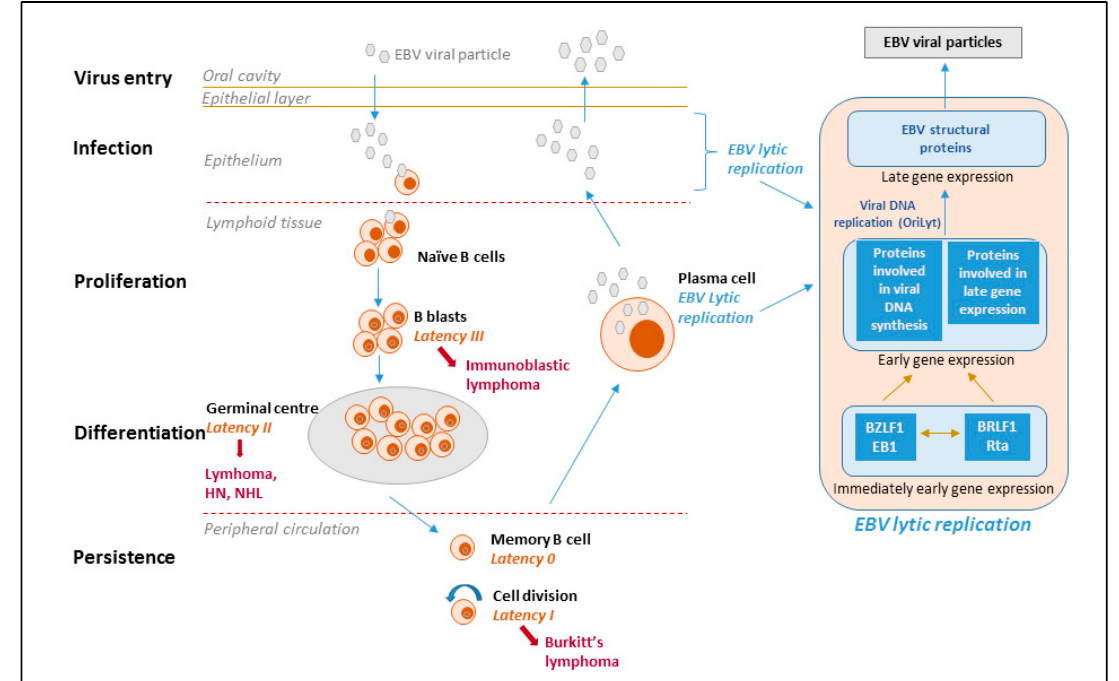
Figure 1. EBV life cycle, latency stages and derived lymphomas. The viral life cycle includes at least five different stages (virus entry, infection, proliferation, differentiation and persistence), and four of them are associated with EBV diseases. The virus is transmitted through the saliva and infects naïve B-cells in the oropharyngeal mucosa. During primary infection, EBV-infected naïve B-cells express the entire latency gene complex (10 proteins: EBV nuclear antigens (EBNAs), latent membrane protein (LMPs)) as well as EBV-encoded small RNAs (EBERs) and microRNAs. This is called type III latency and this form of latency activates the resting B-cells and drives them to proliferation and transformation. However, these cells are highly immunogenic and are rapidly eliminated by EBV-specific T cells. The virus is able to survive in B-cells because it downregulates its immunogenic proteins. EBV mimics antigen driven B-cell responses and similar to antigen-stimulated blasts, the EBV-infected B-cells enter the follicles, expand, and form germinal centers where they express only three viral proteins (type II latency). Finally, they exit the lymph node expressing only a single viral protein (EBNA1, which ensures that the viral genome divides with the cellular genome) (type I latency). The entry of EBV-infected cells into the peripheral blood results in the shutdown of all viral genes encoding for proteins; this is called latency 0 or latency program where no viral proteins are expressed. Resting memory cells, in which the virus is quiescent, are not attacked by the host immune system and are likely the sites of long-term persistence. Memory B cells occasionally divide to maintain stable number of cells and when a cell that is carrying the virus divides, the viral EBNA1 protein is expressed to allow the viral genome to replicate along with the cell. Memory B-cells may also undergo terminal differentiation into plasma cells and secrete antibodies. If such a cell contains the virus, the EBV lytic program is activated and the infectious virus released from the plasma cells can infect epithelial cells, where the virus can replicate and be shed at high amounts and then be transmitted to other hosts. With the exception of latency type 0, each latency state is found in specific types of EBV-associated malignancies.